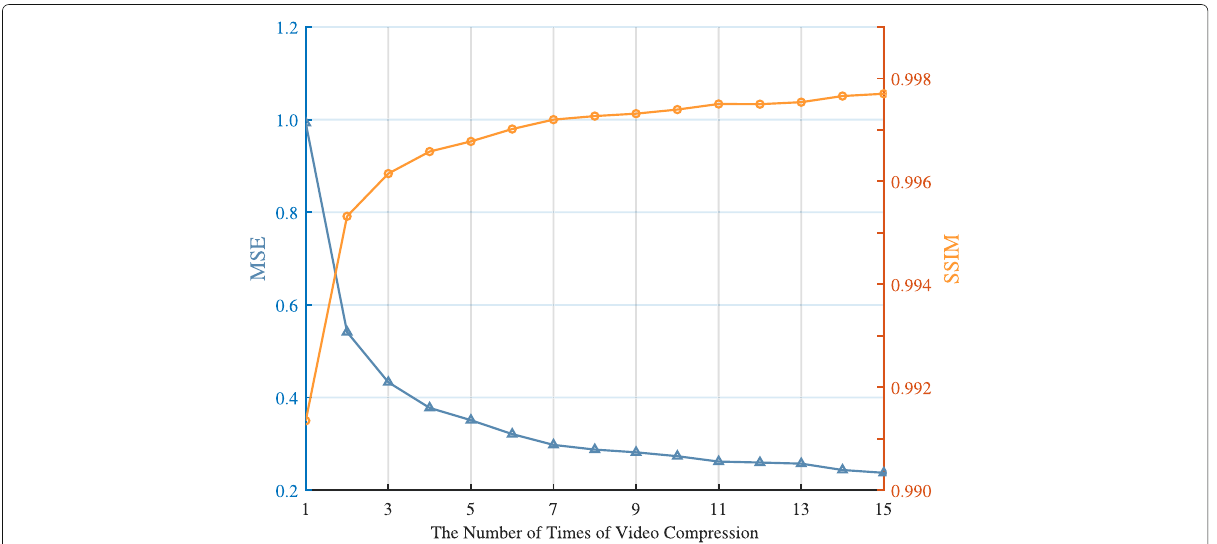
Fig. 7 The MSE and SSIM of videos before and after compression. The output video of the last compression is used as the input video of the subsequent compression in the experiment